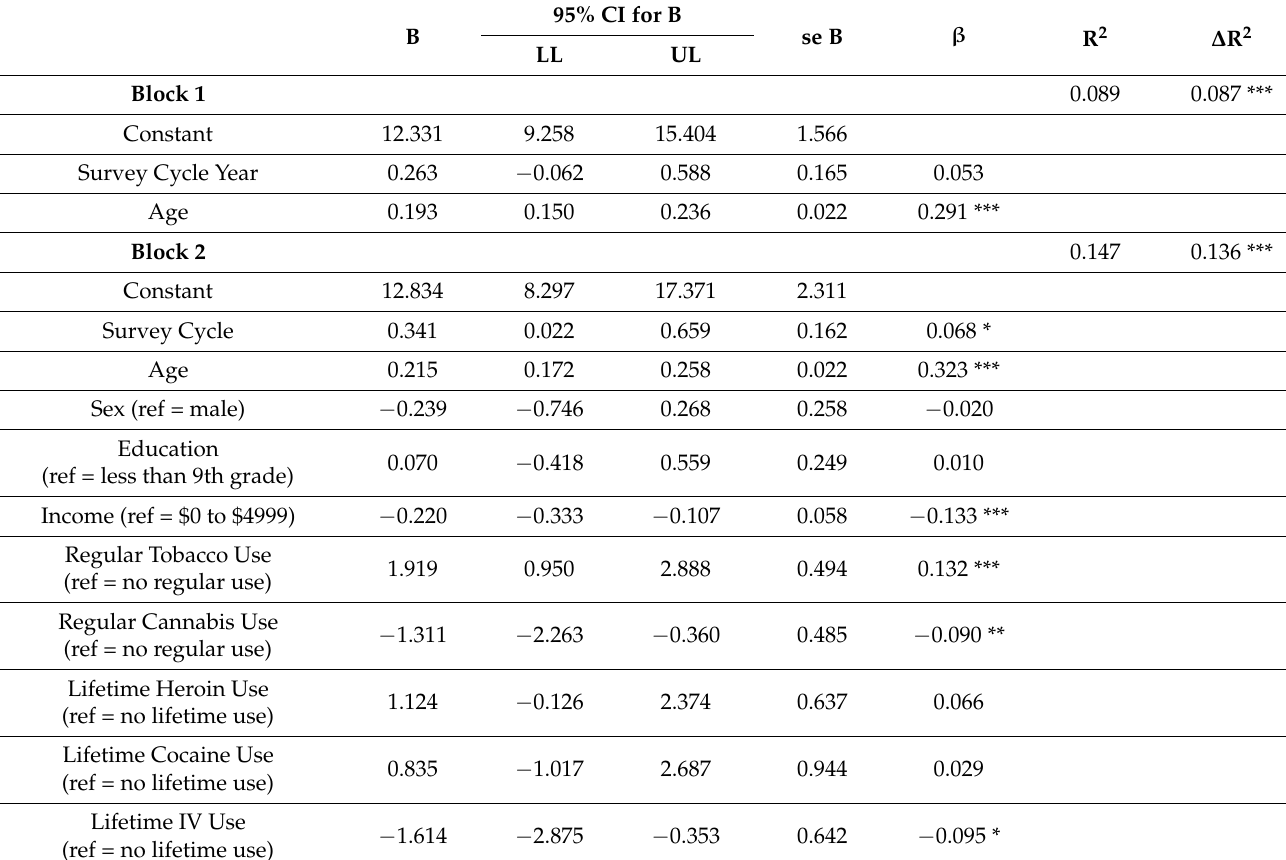
Table 4. Hierarchical multiple regression results for age of onset of methamphetamine use.